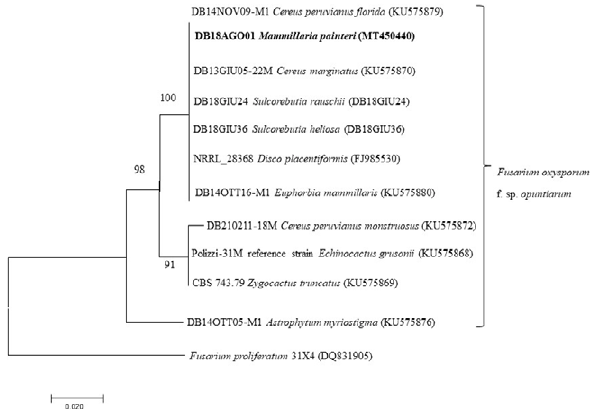
Figure 2. Phylogenetic analysis of a Fusarium oxysporum f. sp. opuntiarum isolate on the basis of intergenic spacer (IGS) sequenc- es, inferred from maximum likelihood analysis. The values at the dendrogram nodes are bootstrap support values based on 1000 replicates. The strain DB18AGO01 from Mammillaria painteri is shown in bold font. The strain 31X4 of Fusarium proliferatum was used as an